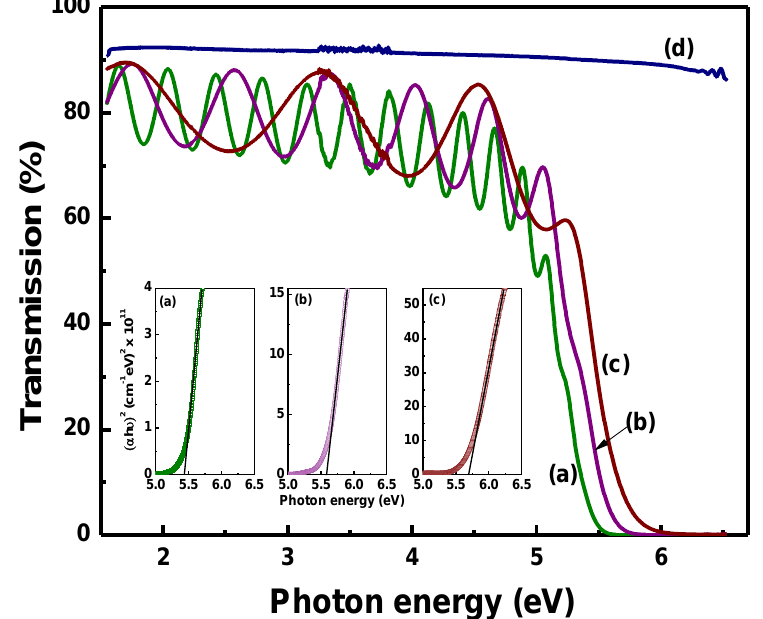
Figure 9. Optical transmittance spectra at normal incidence of amorphous LaGdO films on quartz substrates of ( a ) 725 nm; ( b ) 350 nm; ( c ) 170 nm; and ( d ) quartz substrate. The inset shows the corresponding Tauc’s plots for the three LaGdO ( a ) 725 nm; ( b ) 350 nm and ( c ) 170 nm, to determine the energy bandgap. Reprinted with permission from [19]. Copyright 2012 AIP Publishing